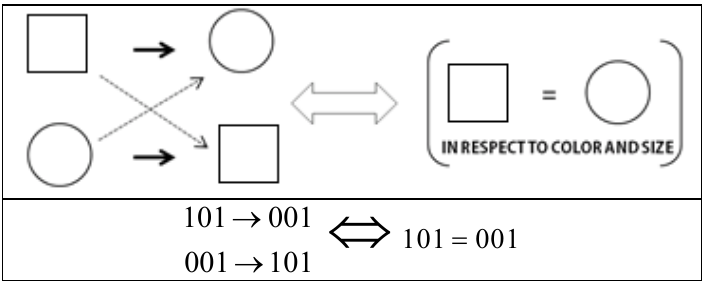
Figure 4. Equivalence of Invariance to partial similarity across two